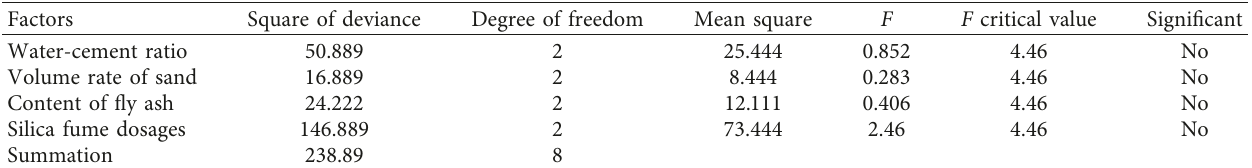
Figure 6: Test results of mechanical properties (slump). Table 4: Analysis of variance